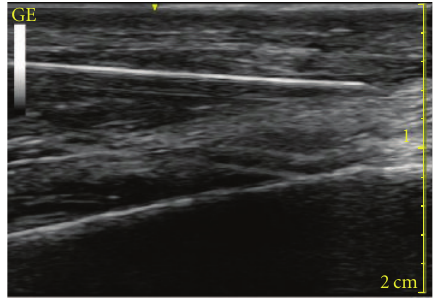
Figure 3: The in-plane view of the cryoprobe and fibula prior to cryolesioning.